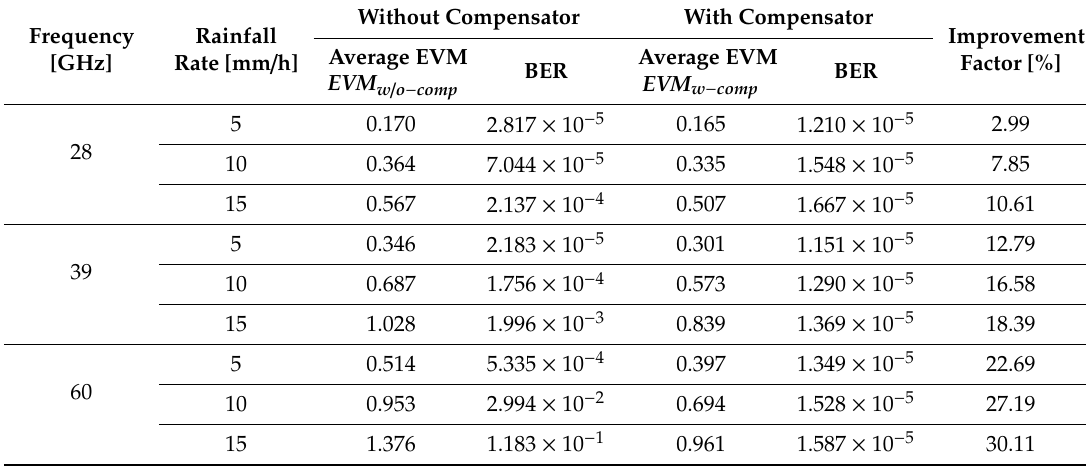
Table 5. Average EVM and BER improvements due to Phase Dispersion Compensation for 200